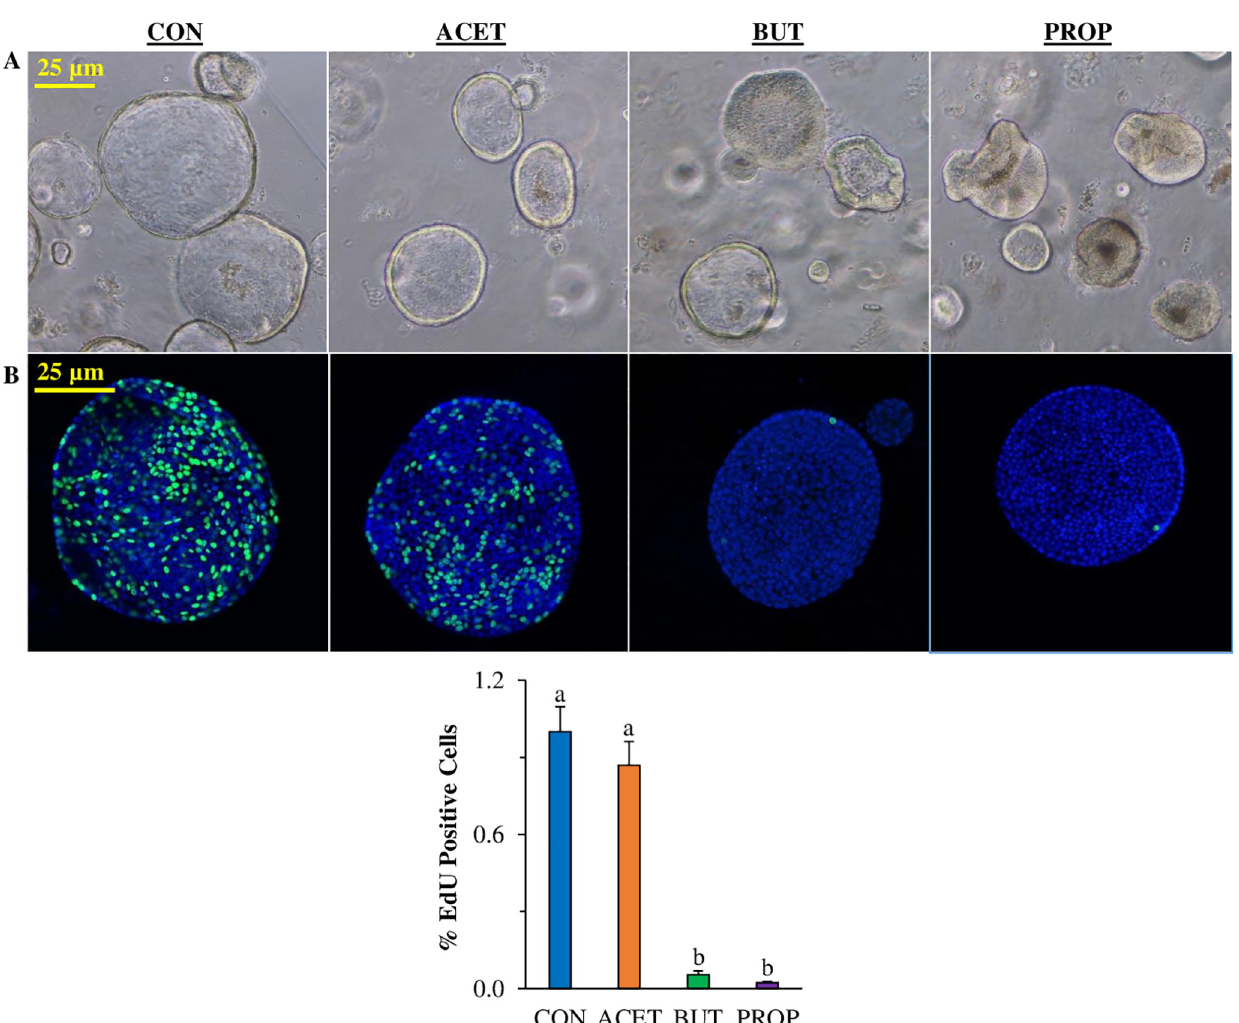
Fig 3. Effect of 24 h treatment with 10 mM acetate (ACET), butyrate (BUT), or propionate (PROP) on morphology of 3D human duodenal enteroids (A) and 3D human small intestinal enteroid cell proliferation (EdU staining, green) compared to controls (CON). Nuclei are stained with DAPI (blue) and images are representative of several fields of view at 20X magnification (B). Treatments are compared to controls (CON) which are set to 1.0 and superscripts (a,b,c,d) indicate statistical significance between treatments at P < 0.05, n =